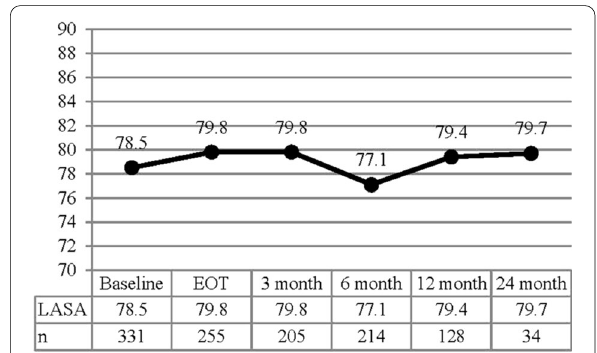
Fig. 1 LASA over time. LASA at each timepoint did not change significantly over time (p 0.7). EOT, end of =